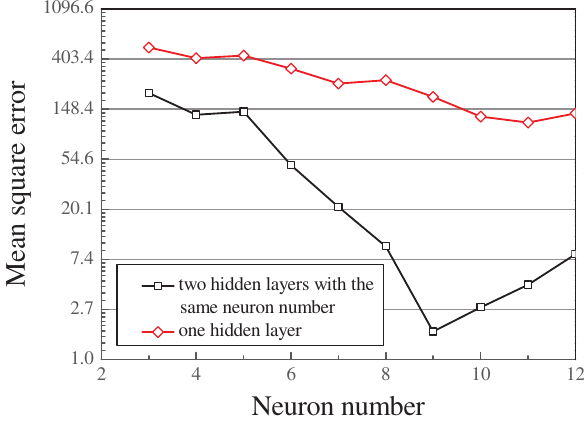
Figure 4: The influences of the hidden layer number and neuron number in each hidden layer on the generalization performance of the neural